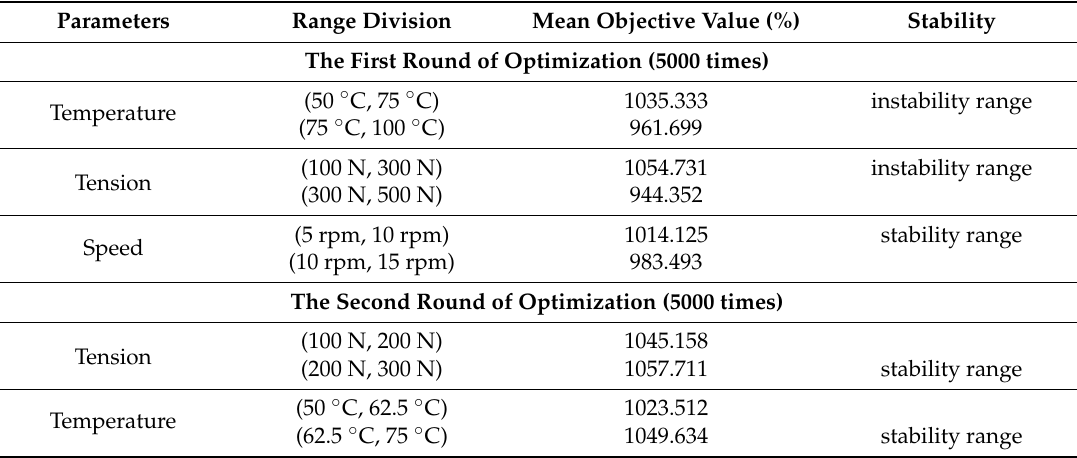
Table 4. Interval optimization for process parameters of the tensile strength model.